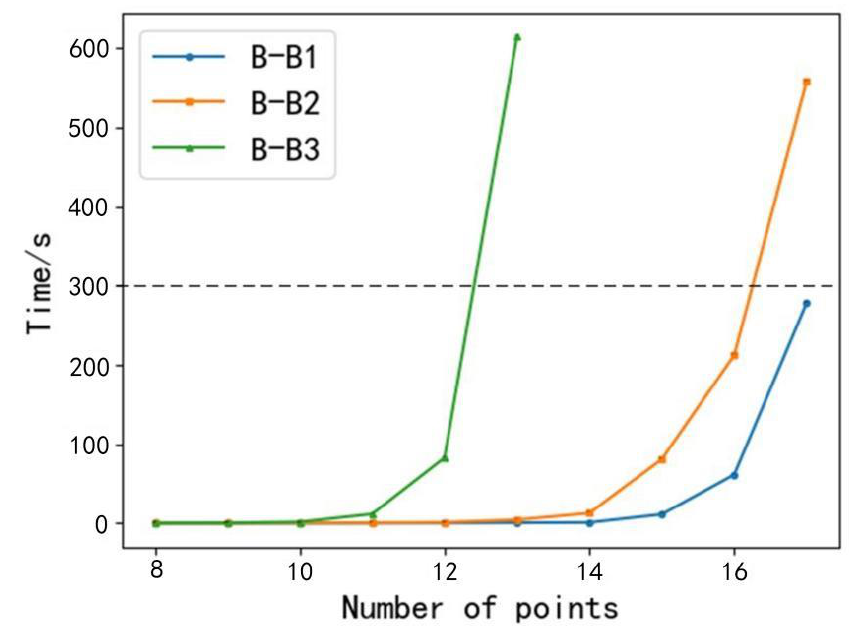
Figure 14. Comparison of the three branch and bound algorithms.